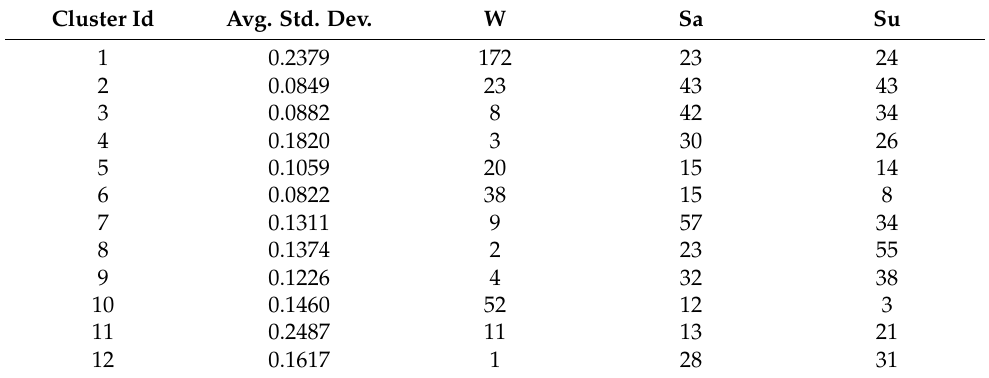
Table 3. Standard Deviation and Population for AP Clusters (W: Working days, Sa: Saturday, Su: Sunday). Cluster